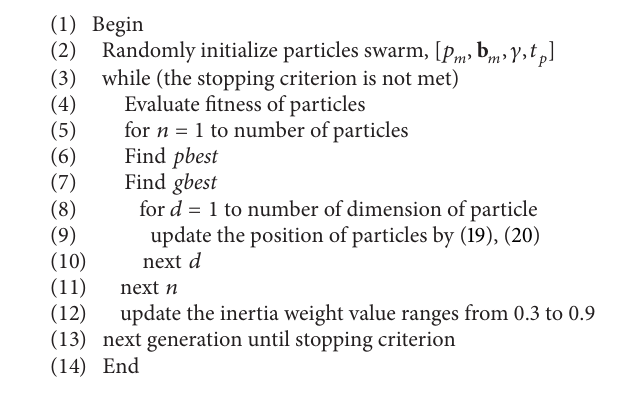
Algorithm 1: Pseudocode for